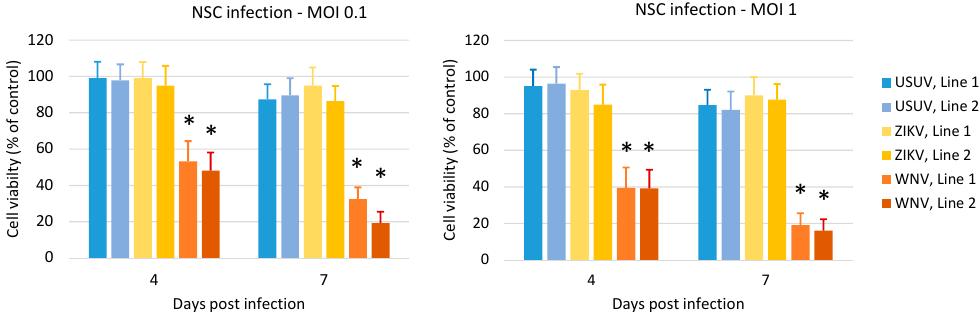
Figure 4. Effect of WNV, USUV and ZIKV infection on NSC viability. Cell viability was measured by MTT assay at 4 and 7 days post infection with WNV lineage 2, USUV Europe 1 and ZIKV Asian lineage at MOI 0.1 and MOI 1. Analysis was performed in eight replicates and repeated in three independent experiments. Data represent mean values ± SD of all experiments. WNV vs. USUV and vs. ZIKV, * p < 0.05, Student’s t-test.